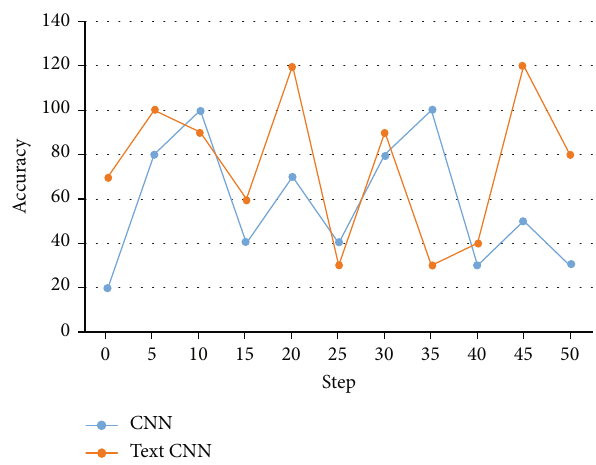
Figure 4: Curve of accuracy rate changing with time during training.